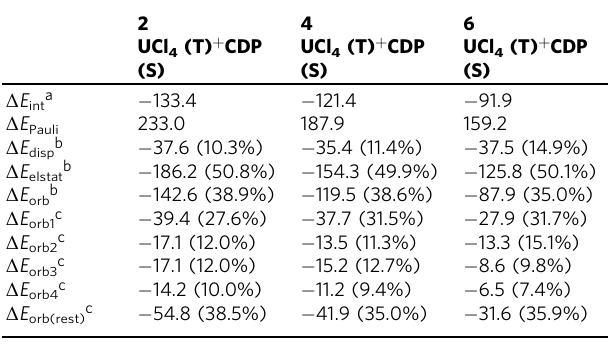
Fig. 3 Magnetic characterization data. Variable-temperature SQUID magnetization data of complex 2 (black square), complex 4 (red circle), and complex 6 (blue triangle) at 0.1 T. Lines are a guide to the eye only